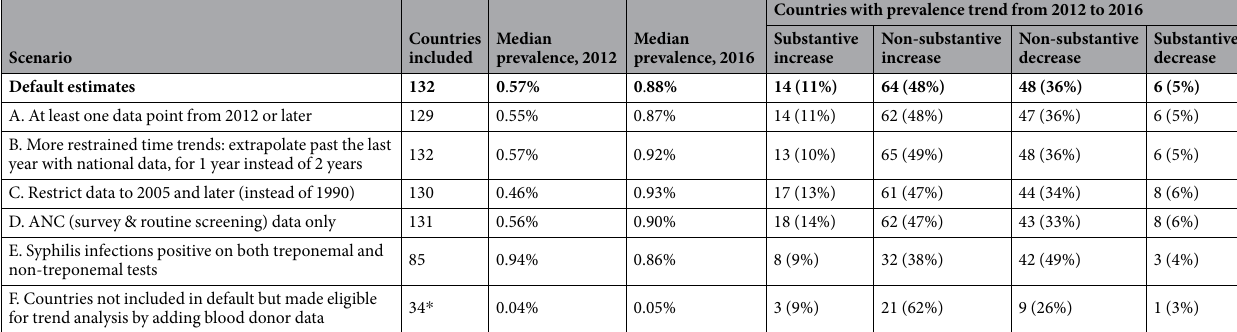
Table 2. Sensitivity analysis: Spectrum-estimated syphilis prevalence in 132 countries, under varying scenarios of data included and modelling assumptions. Notes to Table 2. The presented medians, which are unweighted, should not be interpreted as indicative of global burden trends, as global trends depend on national population sizes. Scenario F presents 34 countries that were not included in the default analysis. In none of the 7 scenarios, none of the countries and none of the years between 2012–2016 was the 20% maximum value imposed on estimated prevalence ever reached, neither in the best estimate (i.e. the median of 400 bootstraps) nor in the upper-bound limit of each corresponding 95% confidence